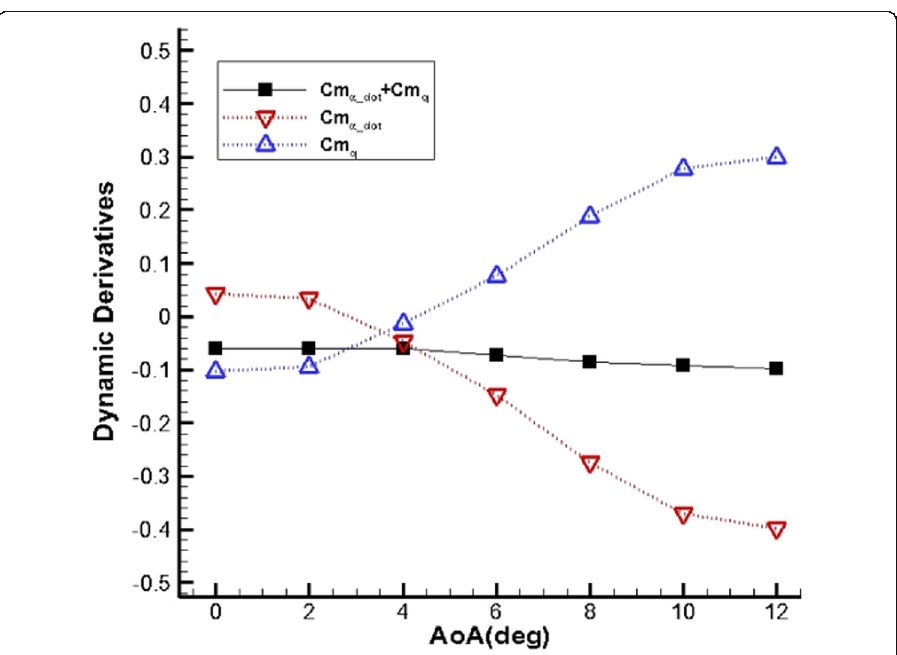
Fig. 11 Components of Dynamic